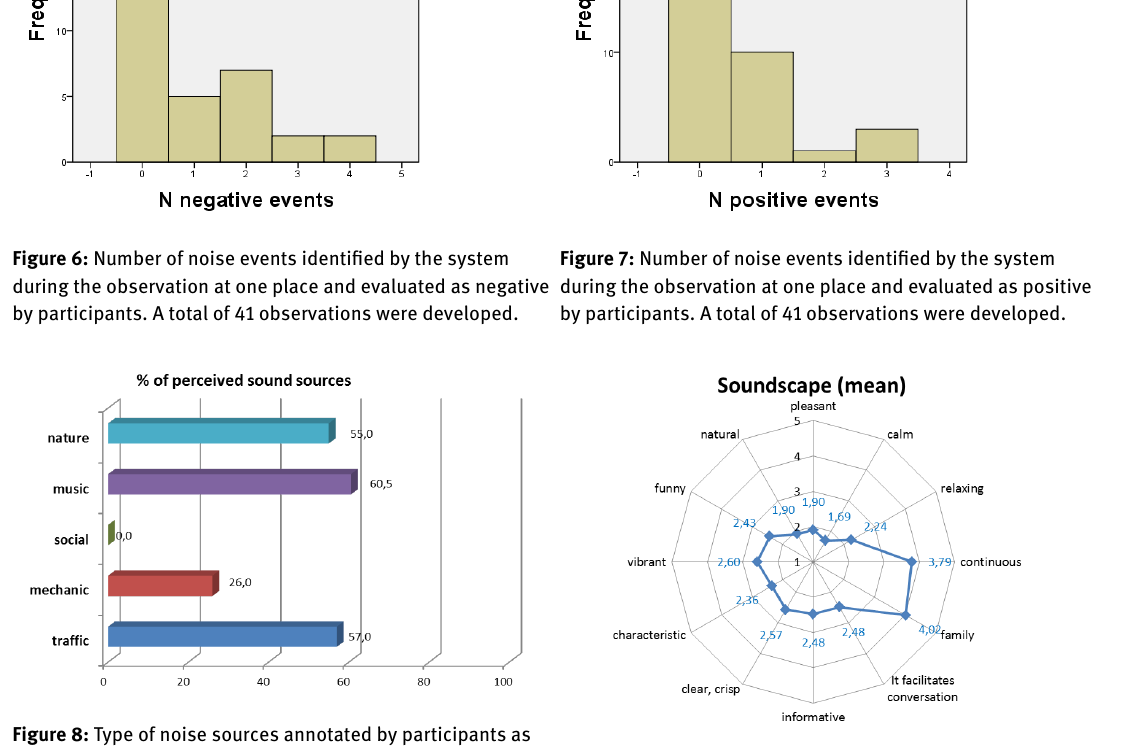
Figure 9: Mean result of the description of soundscape dur- ing the observation assessed by participants at one location (being 5 totally agree and 1 totally disagree). A total of 41 ob- servations were